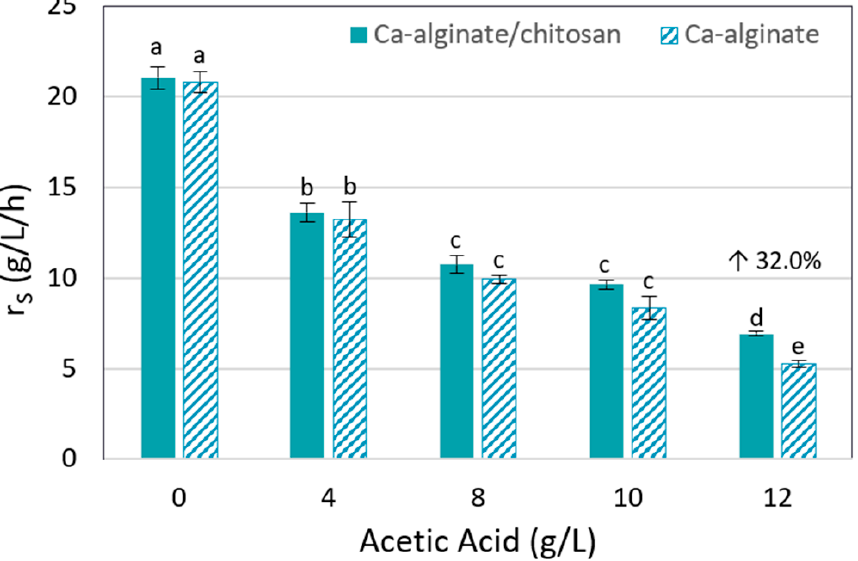
Figure 2. Xylose consumption rate (r S ) in YPX (40 g/L) with different acetic acid concentrations by T18 yeast immobilized in Ca-alginate and Ca-alginate/chitosan gel. Experiments performed with 1:1 V beads /V medium , 35 °C, 150 rpm, and pH 5.2. Increase in xylose consumption represented as percentage (up arrow). (a–e) Matching letters on top of the bars indicate that the means did not differ significantly, according to the Tukey test with 95% confidence level.